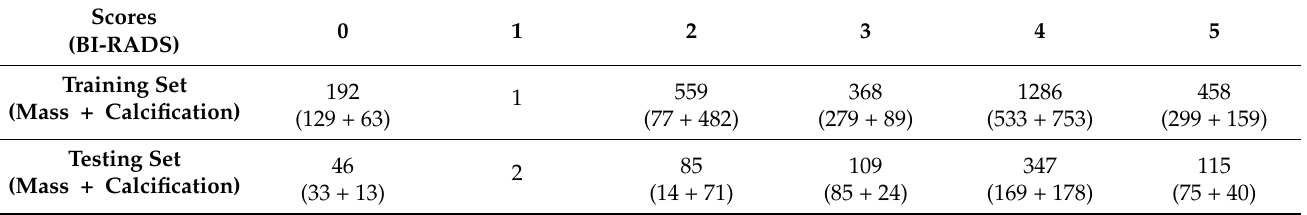
Table 2. Sample distribution of CBIS-DDSM dataset based on BI-RADS assessment.